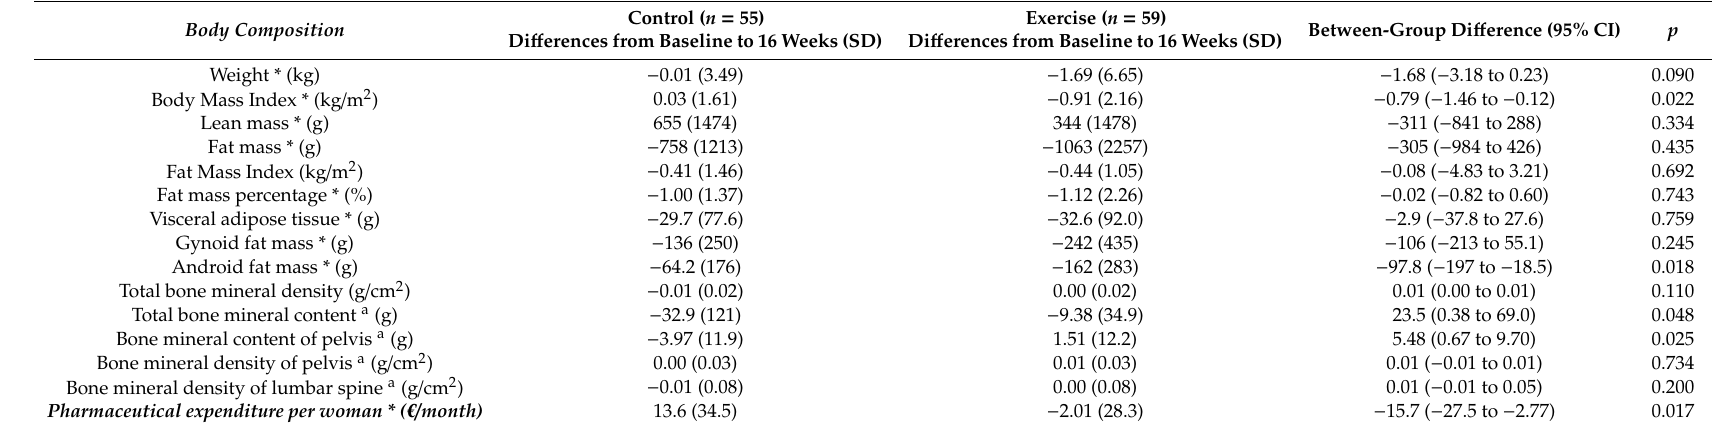
Table 3. Per-protocol analyses showing the e ff ect of a 16-week concurrent exercise program on body composition in perimenopausal women ( n = 114). Body